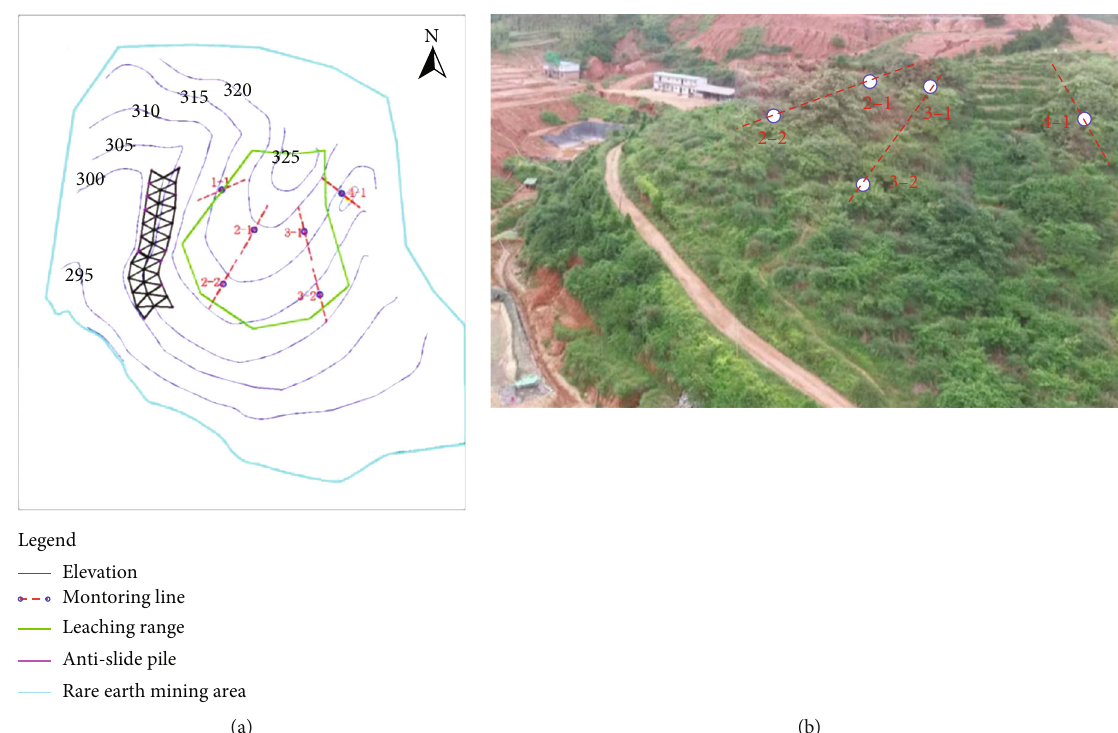
Figure 6: Schematic diagram of the monitoring system. (a) The design of the monitoring point. (b) The location of the monitoring point in the fi